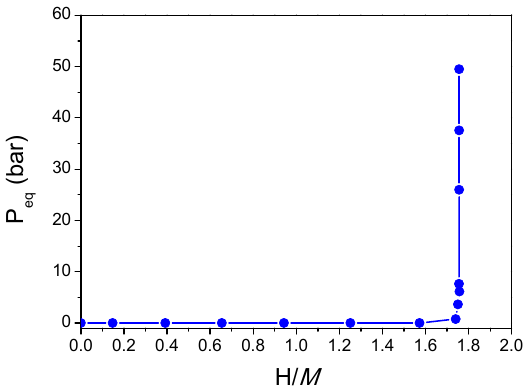
Figure 6. Pressure–composition isotherm for hydrogen absorption in Ti 0.325 V 0.275 Zr 0.125 Nb 0.275 (HT-AM) at 25 °C.